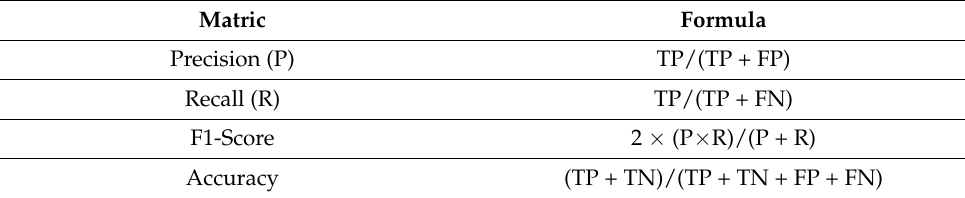
Table 3. Measures used for model